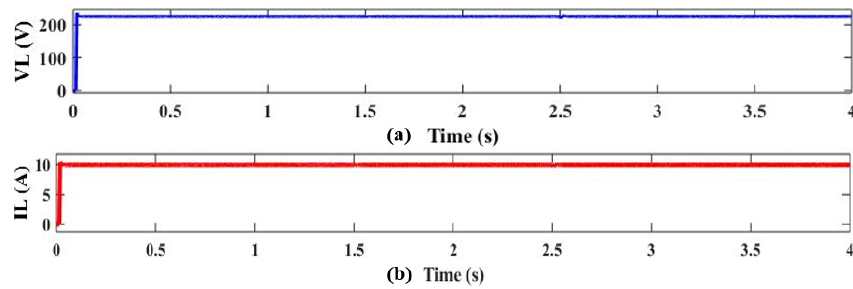
Figure 16. ( a ) Output voltage ( b ) Output current.